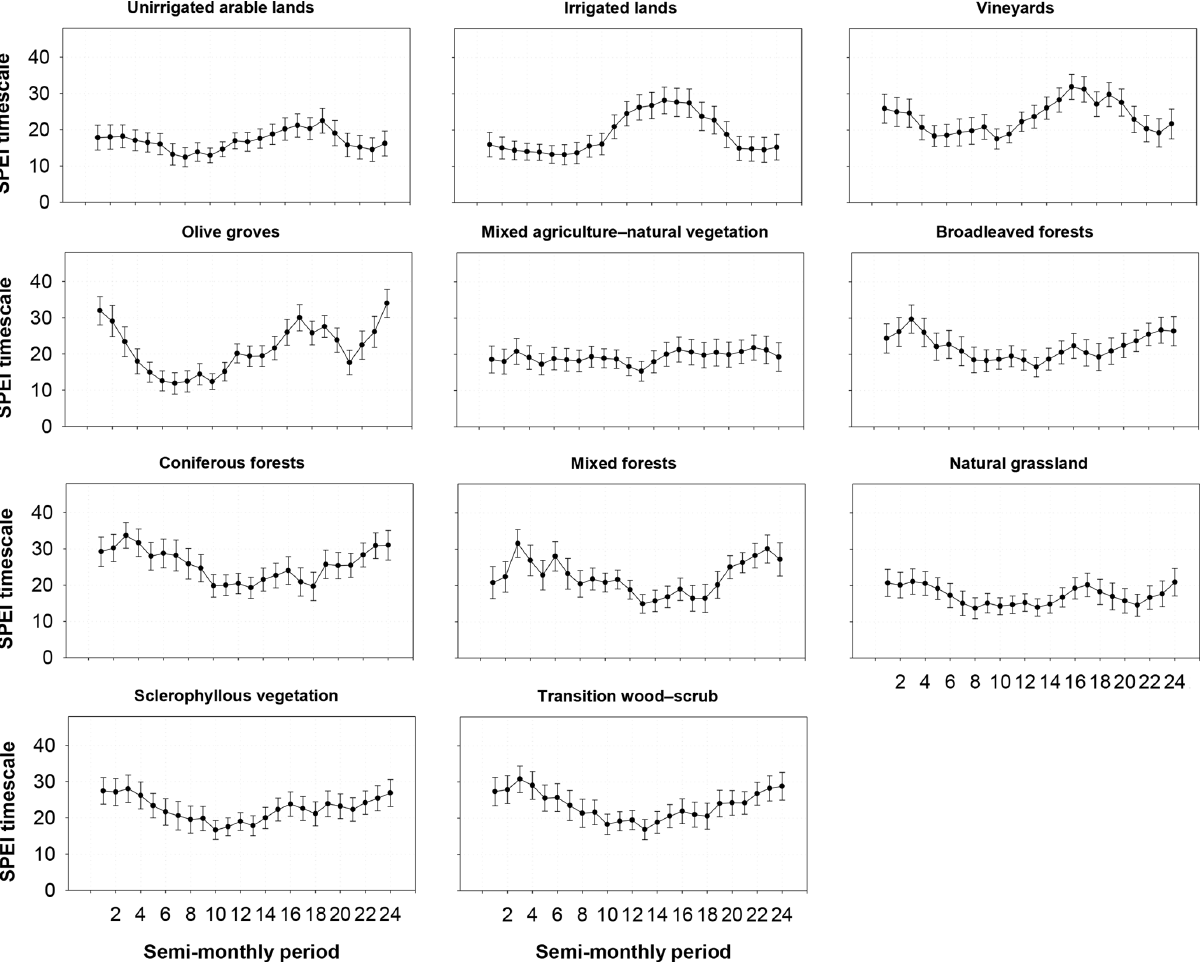
Figure 7. Average and standard error of the SPEI timescale at which the maximum Pearson’s r correlation coefficient was found between the sNDVI and SPEI for the different land cover